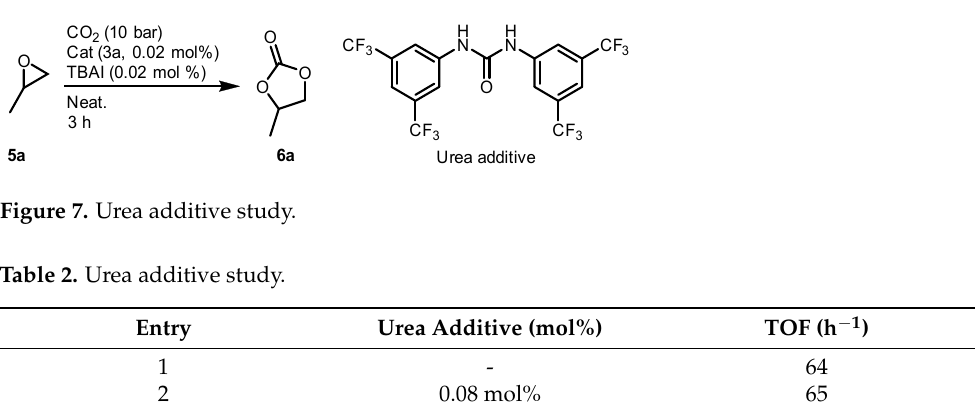
Figure 8. Kinetic analysis of the reaction order (Second order, R 2 = 0.9977). Reaction conditions: